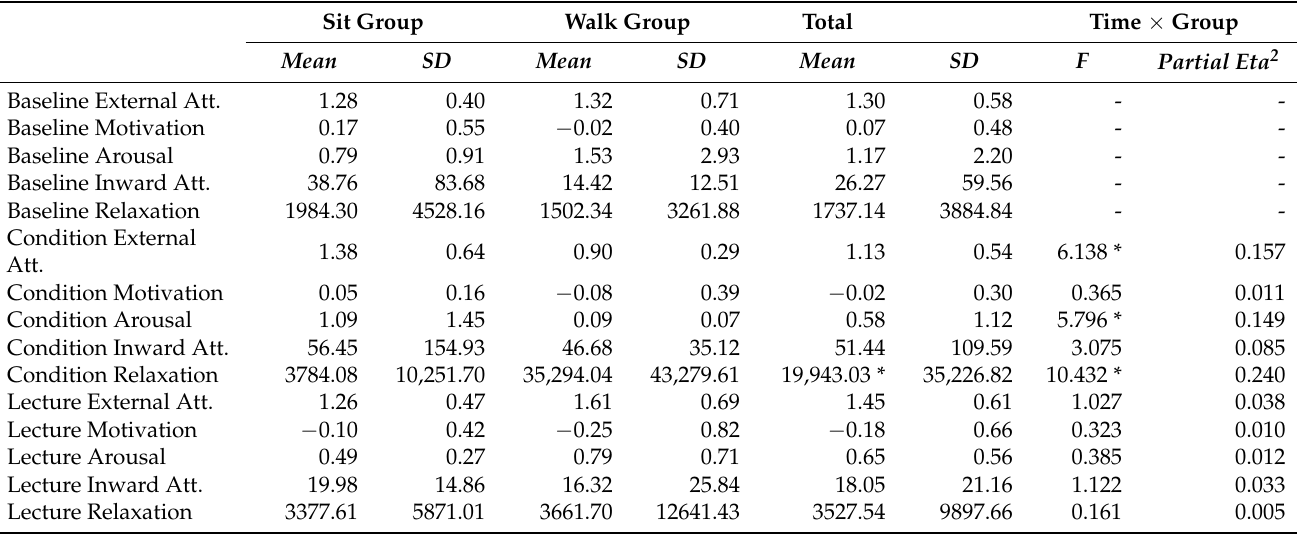
Table 2. RM ANOVA for changes in EEG over three